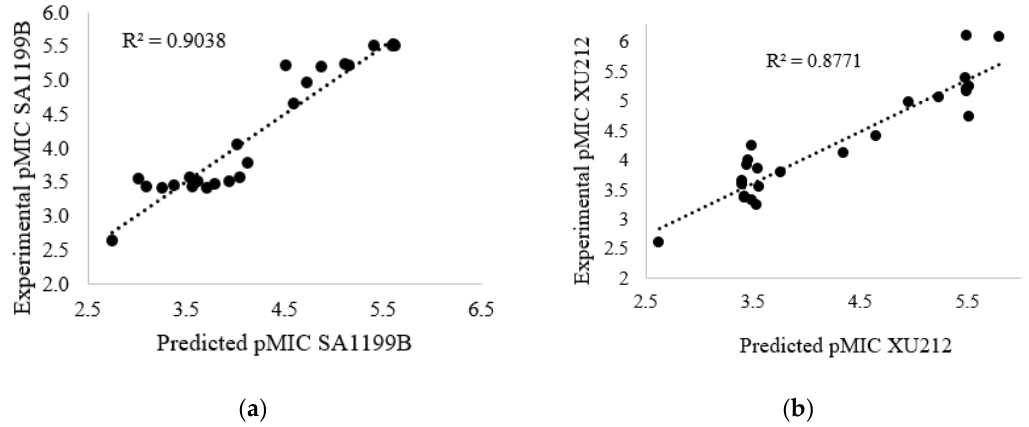
Figure 2. Experimental vs. predicted pMIC. ( a ), predicted by Equation (2); ( b ), predicted by Equation (5).